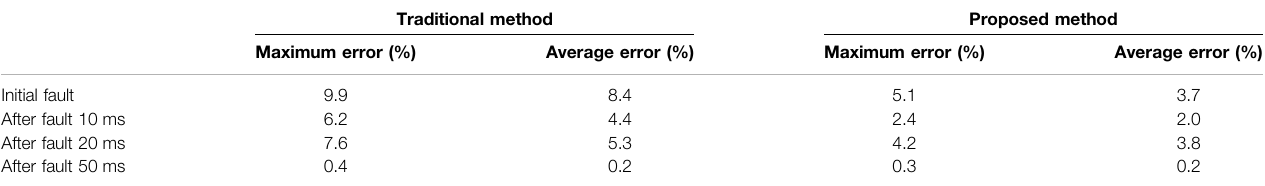
TABLE 1 | Comparison between proposed method calculation result and experimental result with 20 sets of